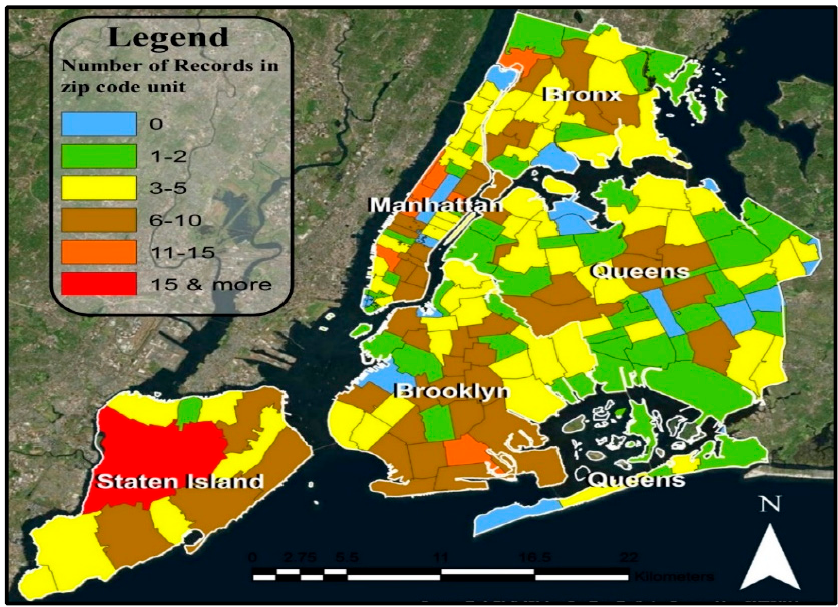
Figure 1. The distribution of dataset records across New York City on zip/postal code level.